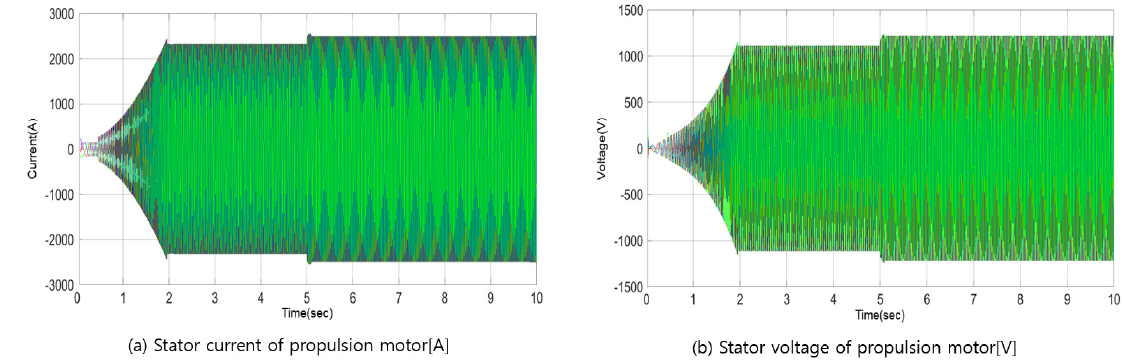
Figure 25. Simulation results of propulsion motor when load varies as 90 → 100%.